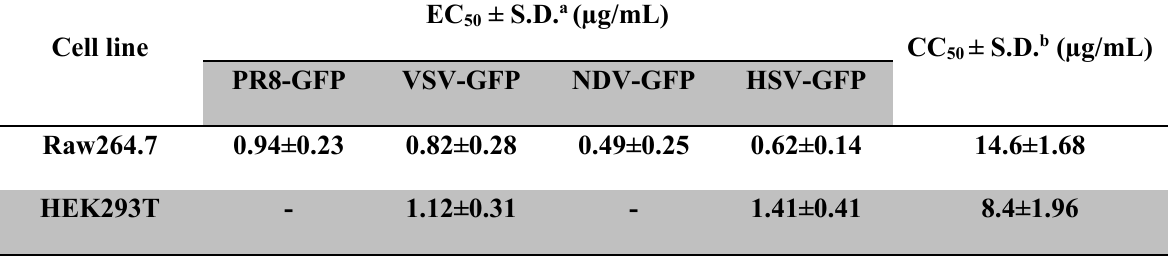
Table 1. Determination of EC 50 and CC 50 of Epimedium koreanum Nakai in RAW264.7 and HEK293T